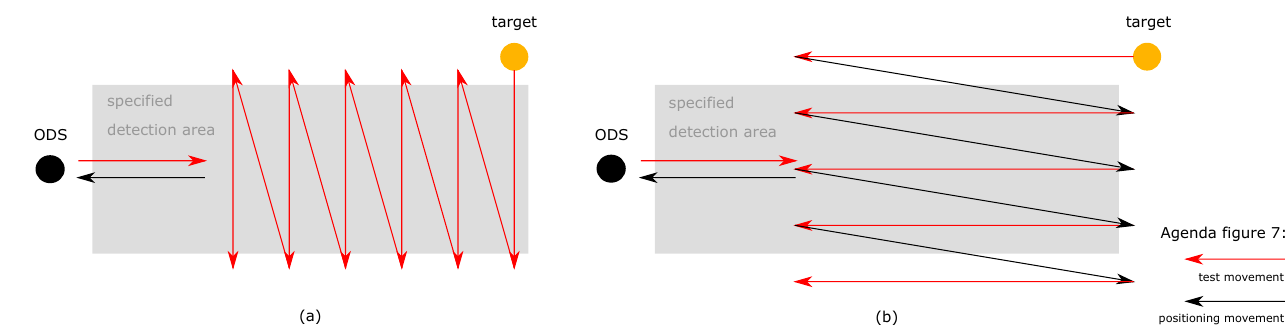
Figure 7. In the third test scenario, the ODS and the test target are in dynamic state. The test scenario is divided in a lateral and longitudinal part: ( a ) In the lateral part, the ODSs are moved forward and the test target is moved into the SDA from the left to right in “zig-zag” movement from the ODS point of view at the same time; ( b ) in the longitudinal part, the ODSs are moved forward and the test target is moved from back to front in a “zig-zag” movement into the SDA of the ODS from the point of view of the ODS. The illustrations show only a schematic representation. The size and length ratios can vary.